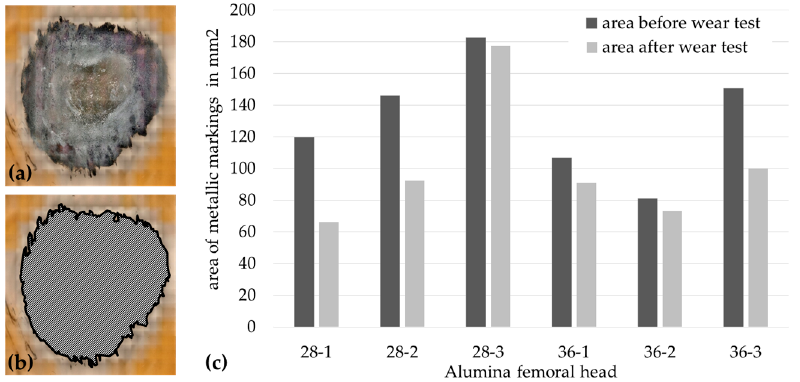
Figure 3. Measurement of metallic deposition areas. ( a ) Metallic depositions, ( b ) marked area for evaluation, and ( c ) recorded values for metallic depositions on retrieved alumina ceramic heads.